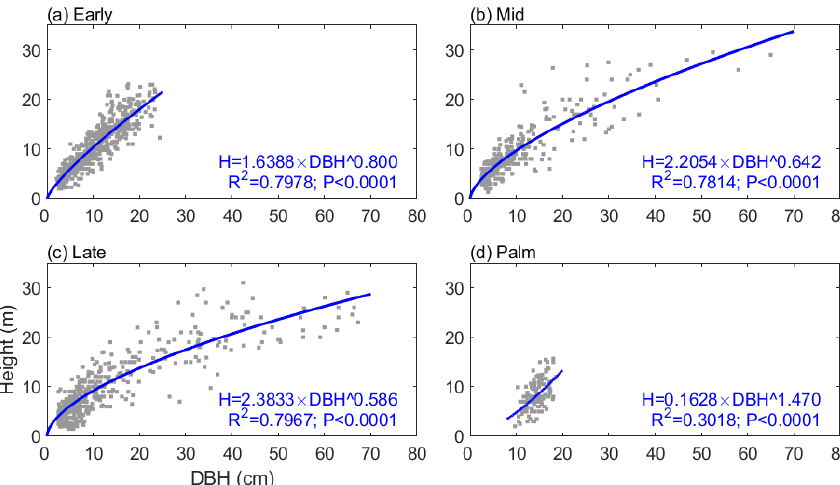
Figure 1. The height–diameter (DBH) relationship for the four PFTs: (a) Early, (b) Mid, (c) Late, and (d) Palm. The gray dots are observations with outliers removed (Sect. S1), and the blue lines are the estimated height–DBH relationship based on these observations. The height–DBH model and the corresponding coefficient of determination ( R 2 ) and p value for each PFT are given at the bottom of each panel.